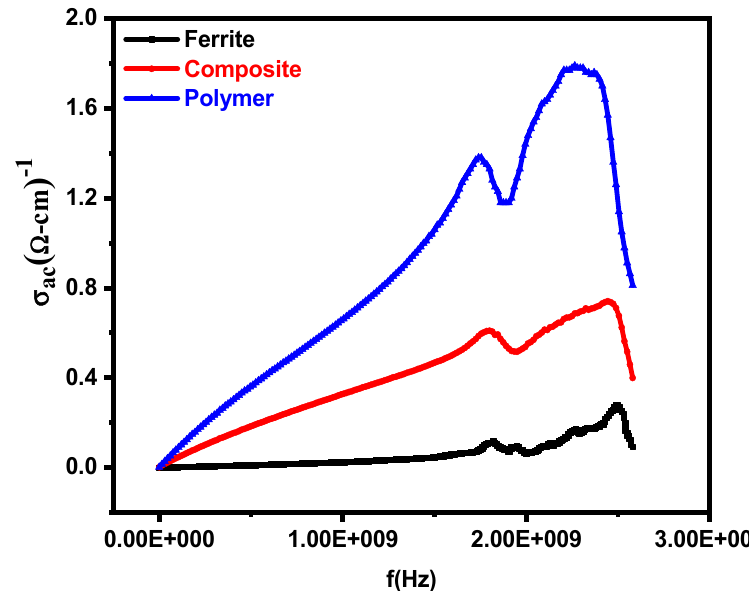
Figure 5. The plot of AC conductivity vs. frequency of Y-type hexaferrite Sr 2 Co 2 Fe 12 O 22 , composite (Sr 2 Co 2 Fe 12 O 22 + PPy-DBSA) and polymer PPy-DBSA.